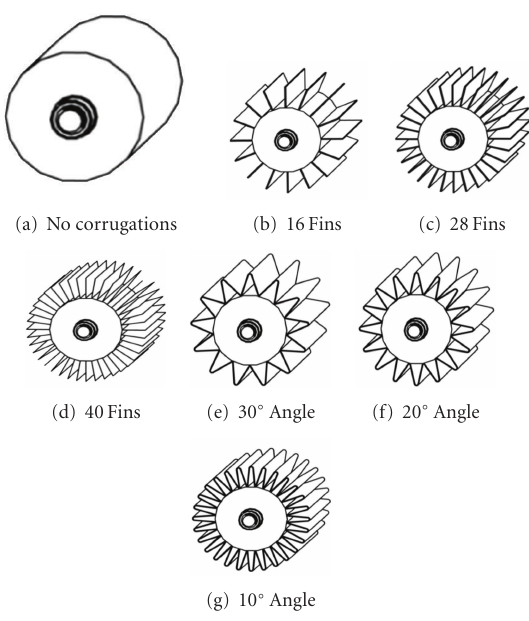
Figure 2: Reactor drum